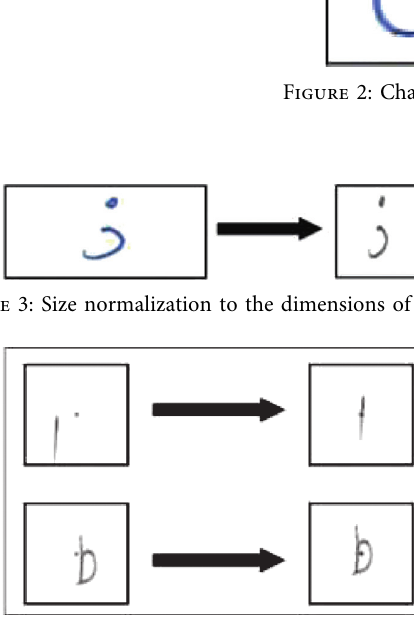
Figure 4: Centralization of characters “alif” and “twe.” Figure 5: Character ‘bhe’ divided into 64 zones of 8 × 8